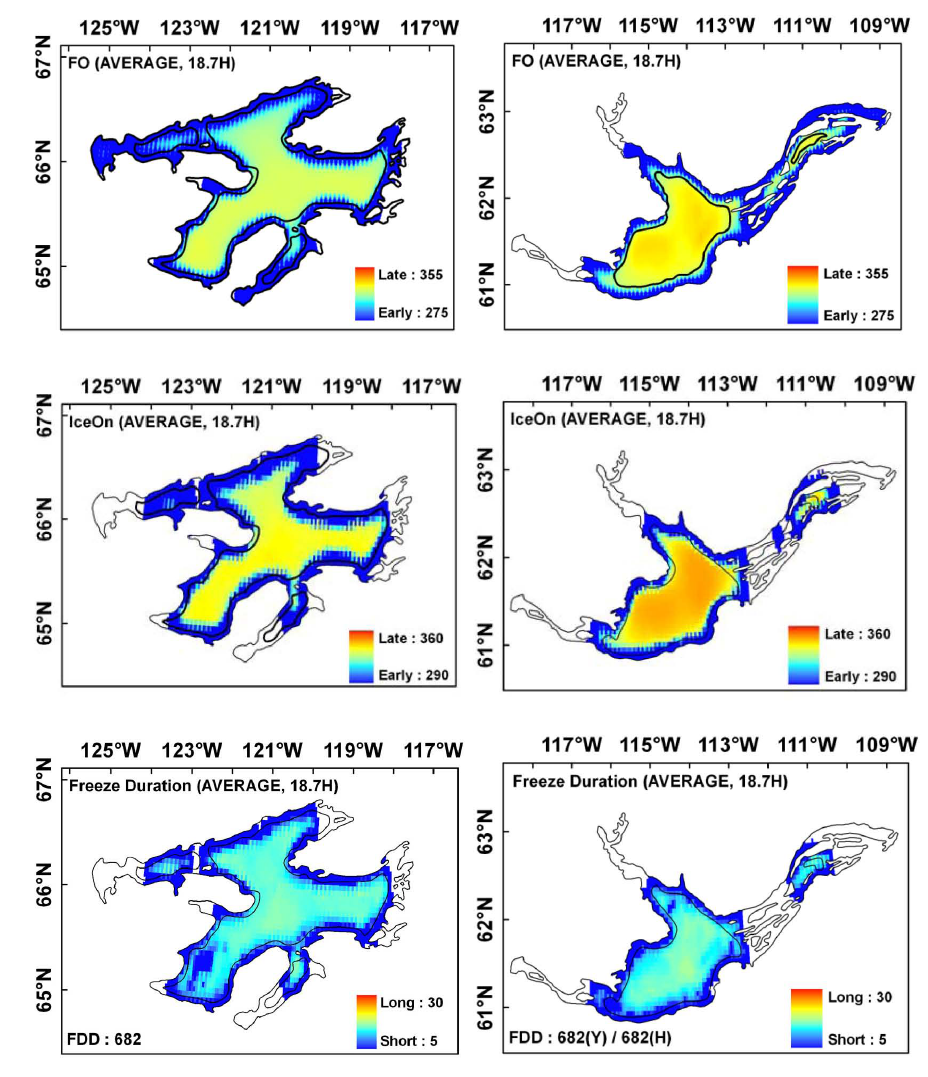
Fig. 4. Freeze-onset (FO), ice-on, and freeze-duration on average (2002–2009) for GBL (left panel) and GSL (right panel). Legend is day of